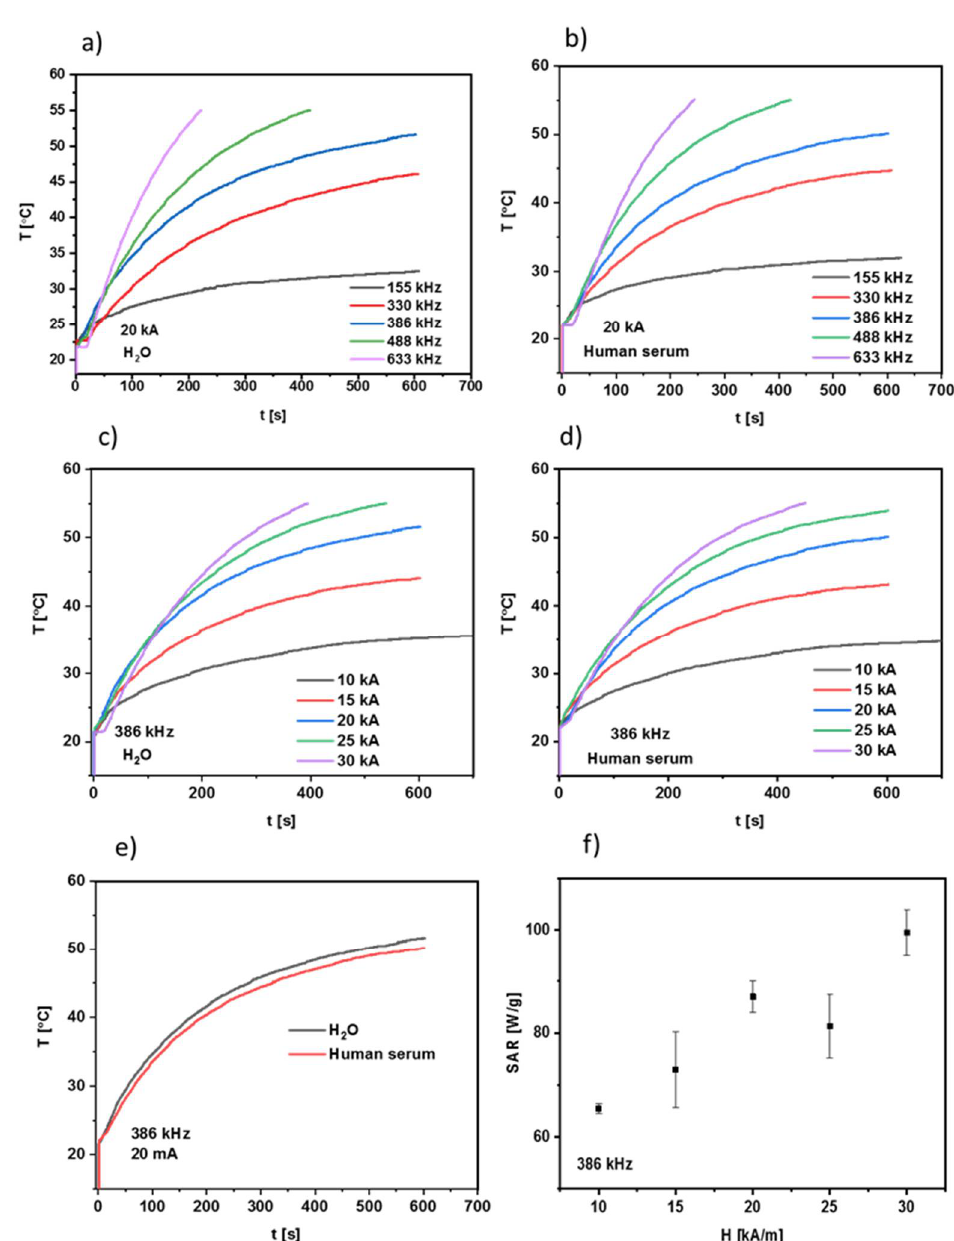
Figure 10. Heating of bioconjugate: ( a ) water DI, 155–633 kHz at 20 kA/m, ( b ) human serum, 155–633 kHz at 20 kA/m, ( c ) water DI, 386 kHz at 10–30 kA/m, ( d ) human serum, 386 kHz at 10–30 kA/m, ( e ) water DI and human serum, 386 kHz at 20 kA/m, ( f ) SAR values for various AMF amplitudes at 386 kHz. Data are expressed as mean ± (n = 3).